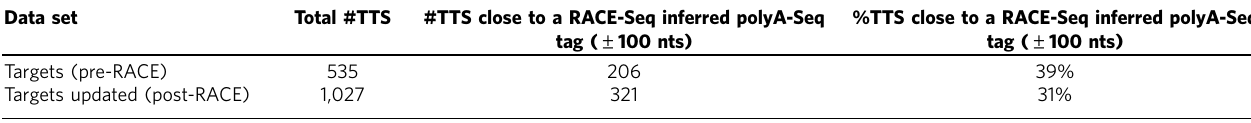
Table 2 | Comparison of pre- and post-RACE TTSs data sets with polyA peaks called using our RACE-Seq data. Data